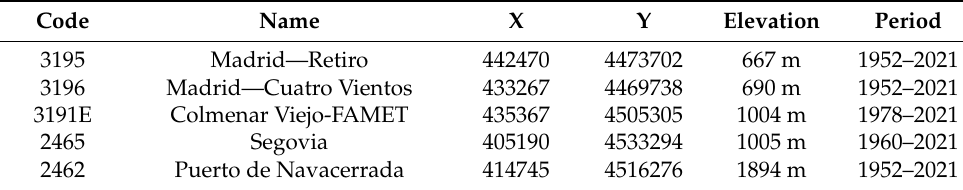
Figure 1. Location of the studied meteorological stations. Table 1. Meteorological stations